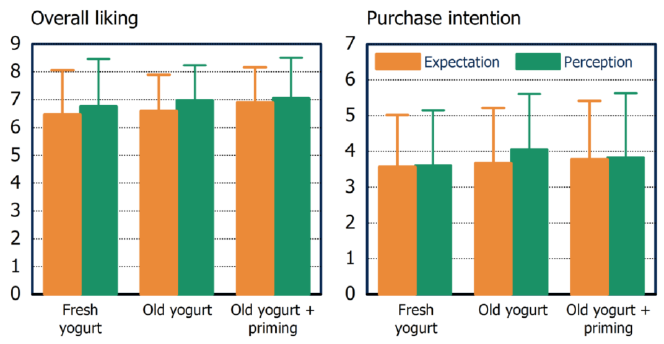
Figure 5. Means of overall liking and purchase intention before (expectation; best-before date was known by the participants) and after tasting yogurt